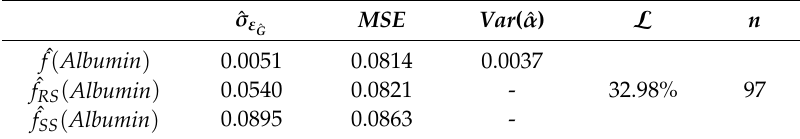
Table 4. Outcomes for the estimated regression model for colon cancer